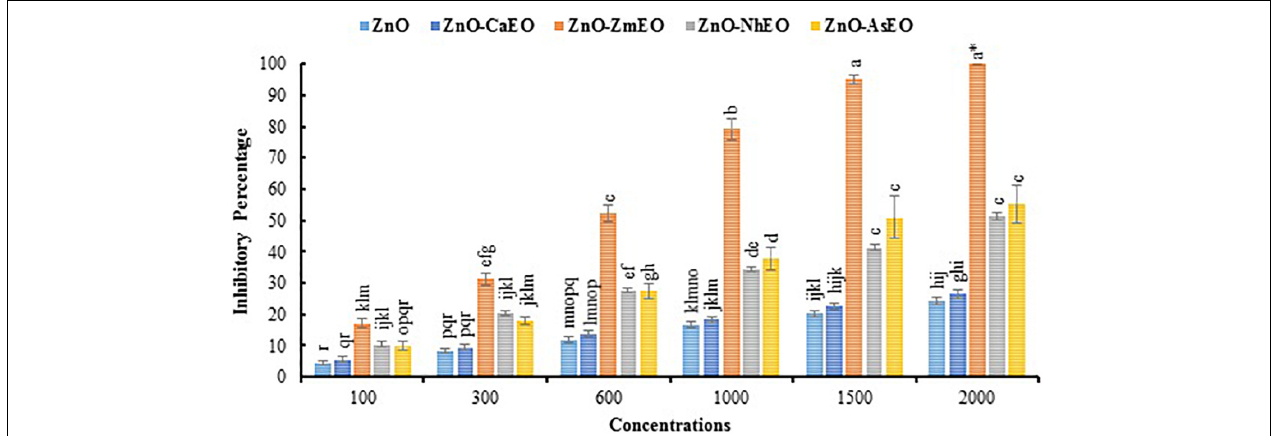
FIGURE 4 | Comparison of mean inhibitory percentage of A. solani mycelial growth with ZnO and nanocapsules of essential oils in vitro . The symbol “ ∗ ” indicates the fungistatic property. TABLE 4 | Probit analysis of data obtained from the inhibitory effect of samples on A. solani in vitro . Samples